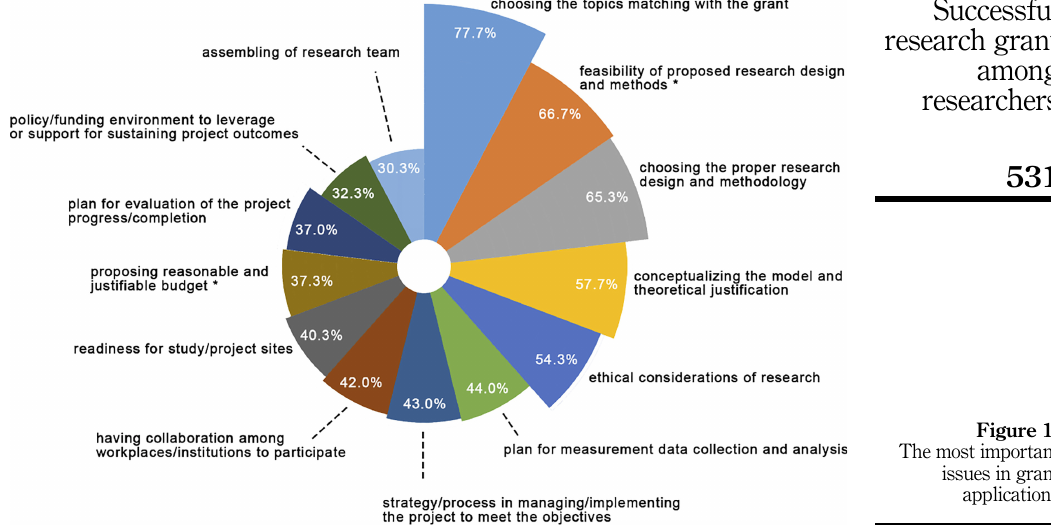
Figure 1. The most